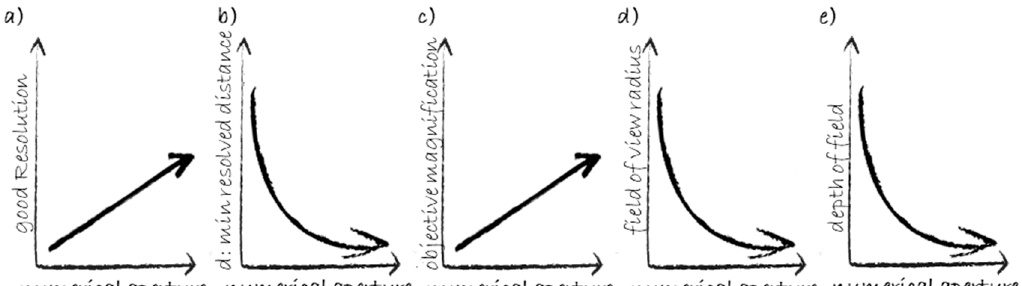
Figure 4. Basic microscopy measures. ( a ) High numerical aperture ensures good resolution (high resolving power). ( b ) The minimum resolved distance “d” between two points of the specimen is the inverse of the resolution. ( c ) Objective magnification usually increases with the numerical aperture. This graph is an empirical approximation. ( d , e ) The radius of the field of view as well as the depth of field are inversely proportional to the numerical aperture.